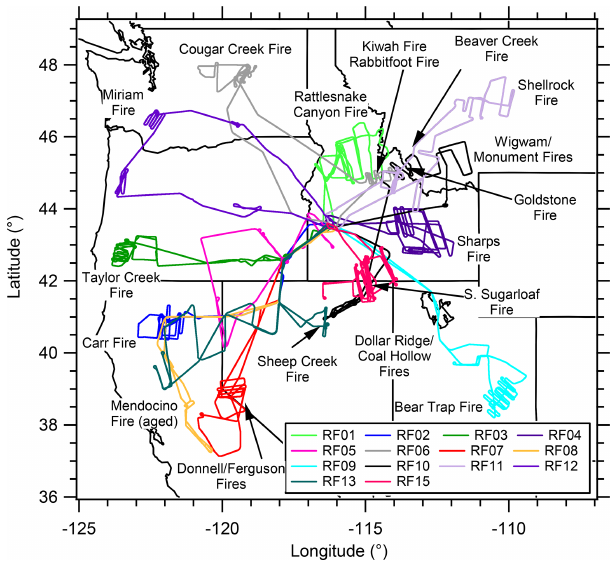
Figure 1. Map showing the flight paths and locations of the wild- fires sampled during WE-CAN used in this